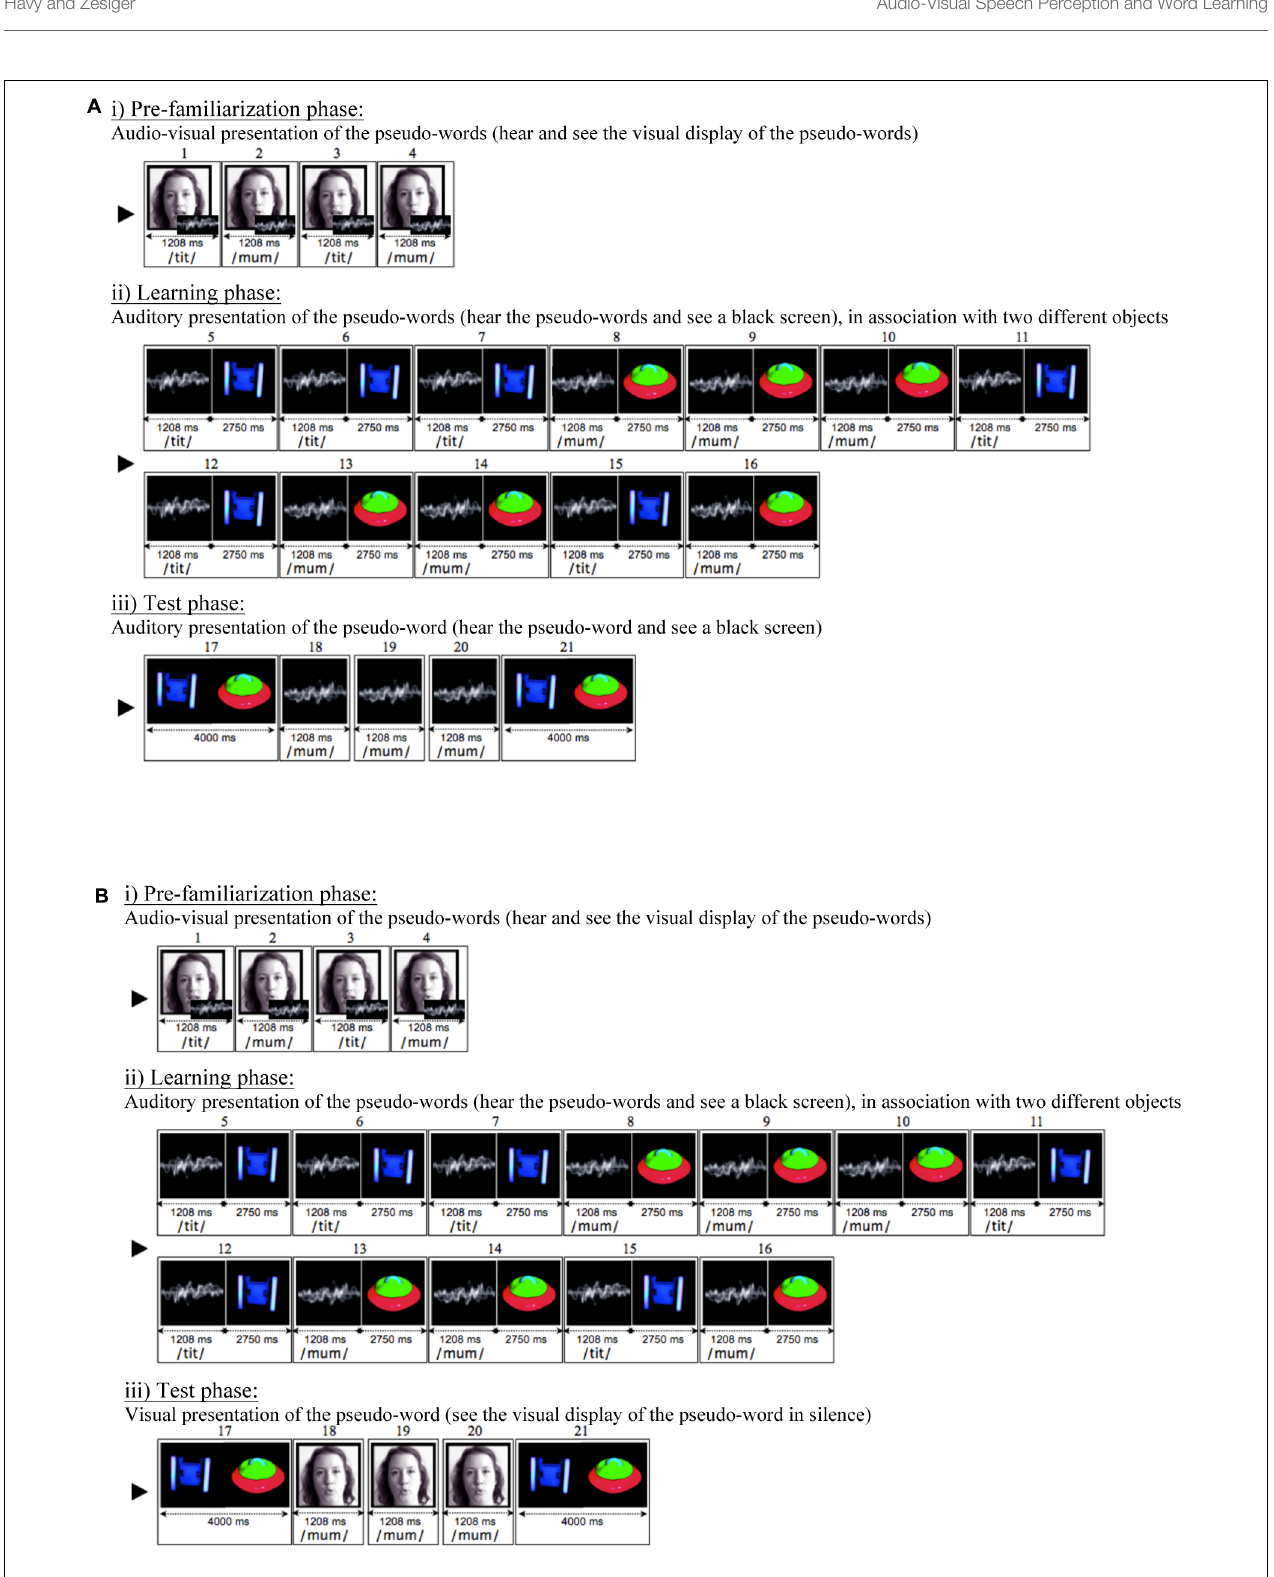
FIGURE 2 | Schematic of a ‘same modality’ (A) and a ‘cross-modality’ (B) test trial in the auditory word-learning condition. The sequences of events are depicted in their actual order (from 1 to 21) for each experimental test trial. The sine wave represents the sound heard and is not actually seen on the screen.